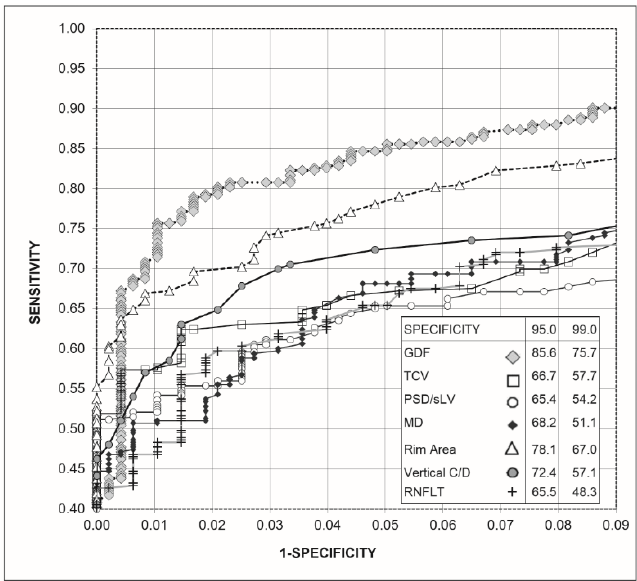
Figure 2. Receiver operating characteristic curve (ROC) obtained with Laguna ONhE (GDF), Cirrus- OCT (rim area, vertical C/D ratio, and RNFLT) and perimetry (MD, TCV, and PSD-sLV) indices, as well as percentage sensitivities for 95% and 99% specificities.